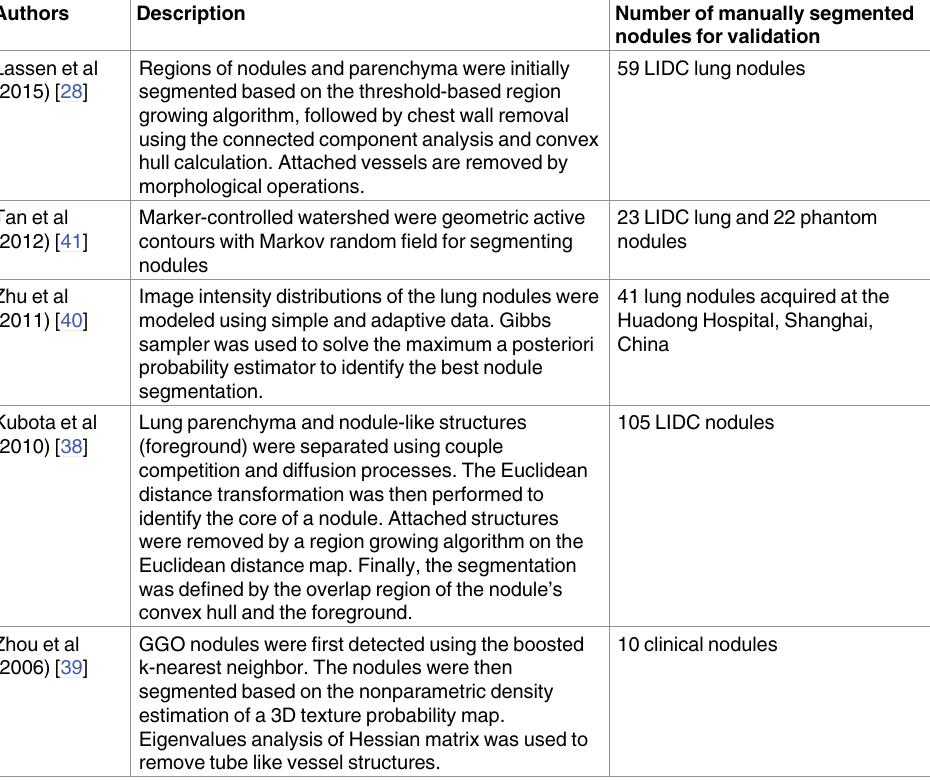
Table 3. Brief descriptions of five algorithms for ground glass opacity (GGO) or partly solid nodule